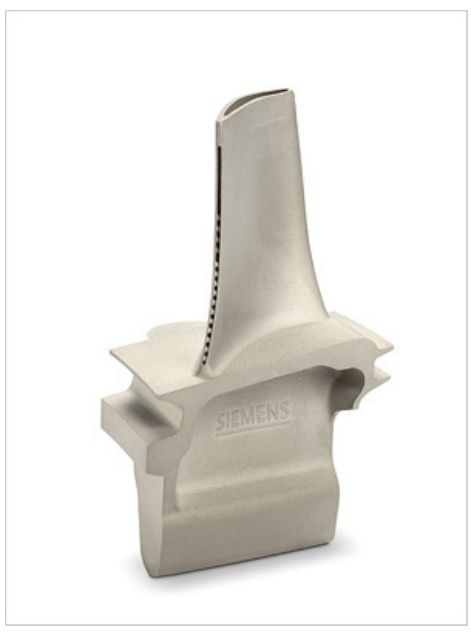
Figure 8. 3D printed Ni alloy based turbine blade by Siemens [85].